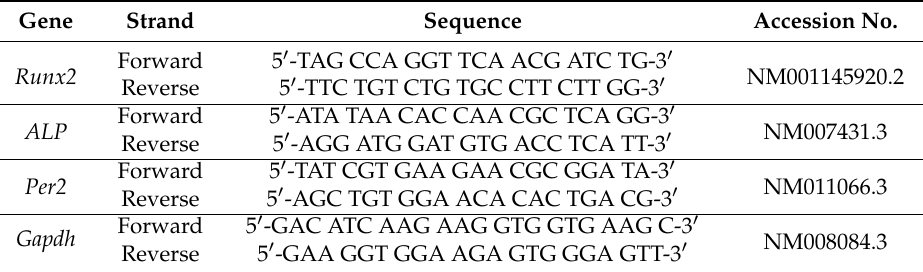
Table 1. Nucleotide sequences of the primer pairs used for real-time